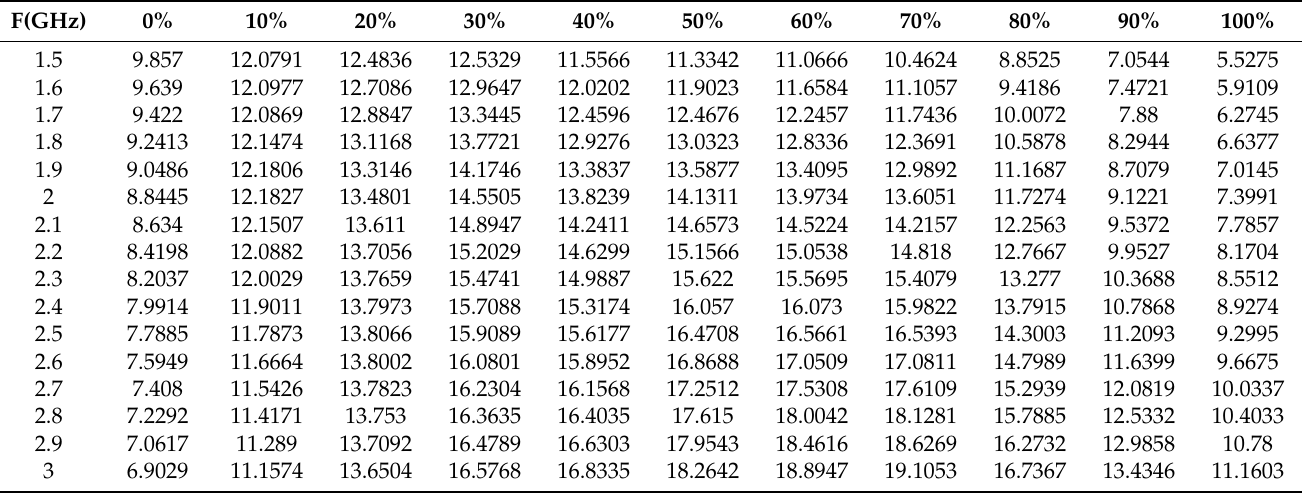
Table A2. Measured imaginary dielectric spectra for water–ethanol mixture at 25 ◦ C and different volume fractions; data reported from